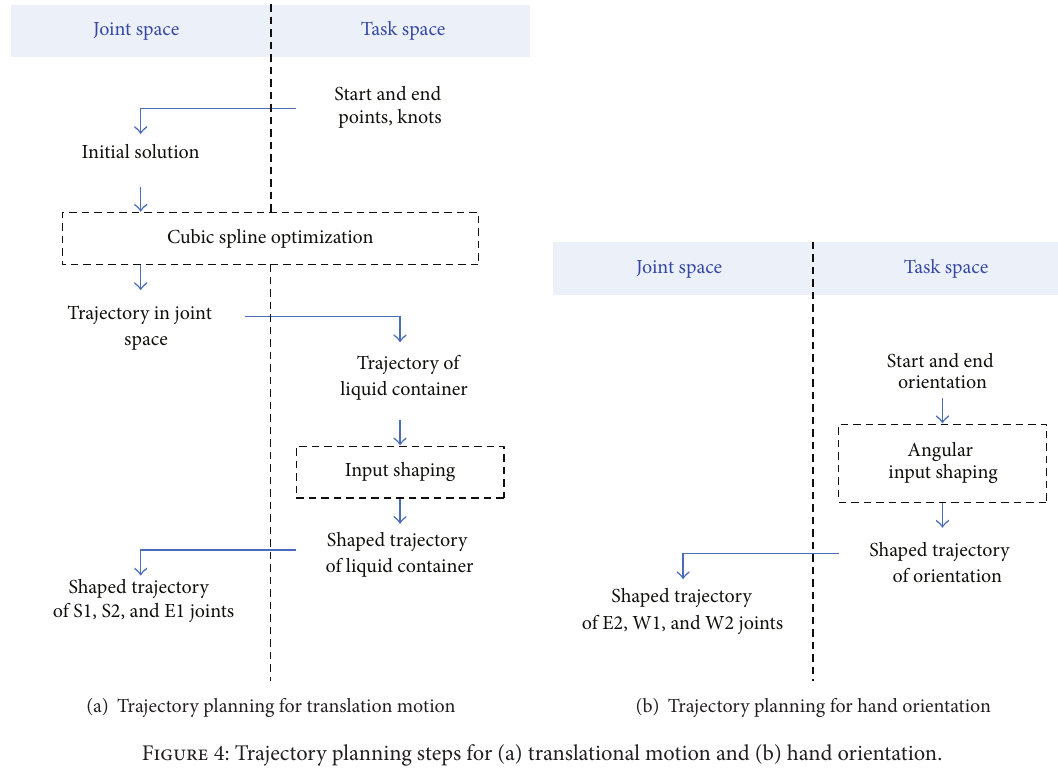
Figure 4: Trajectory planning steps for (a) translational motion and (b) hand orientation.